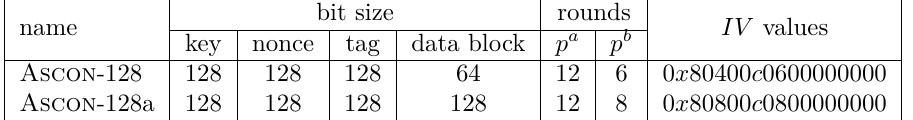
Table 2: Parameters Set for Ascon